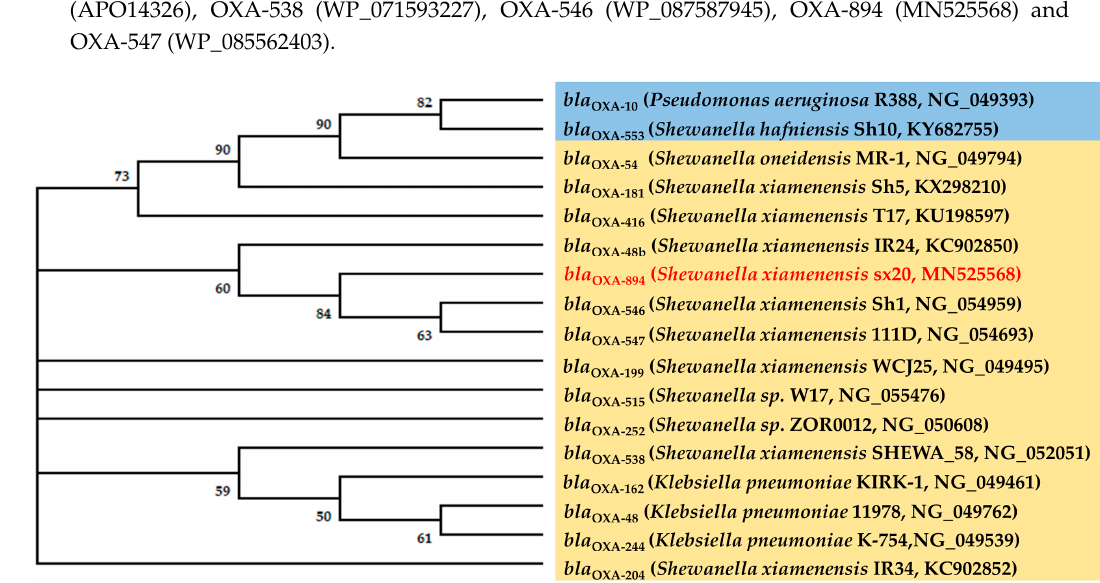
Figure 1. Figure 1. Alignment of the amino acid sequences of OXA ‐ 48 (WP_015059991), OXA ‐ 48b (AGS78031), OXA ‐ 181 (AQU42625), OXA ‐ 199 (WP_063861505), OXA ‐ 204 (AGS78037), OXA ‐ 416 (APO14326), OXA ‐ 538